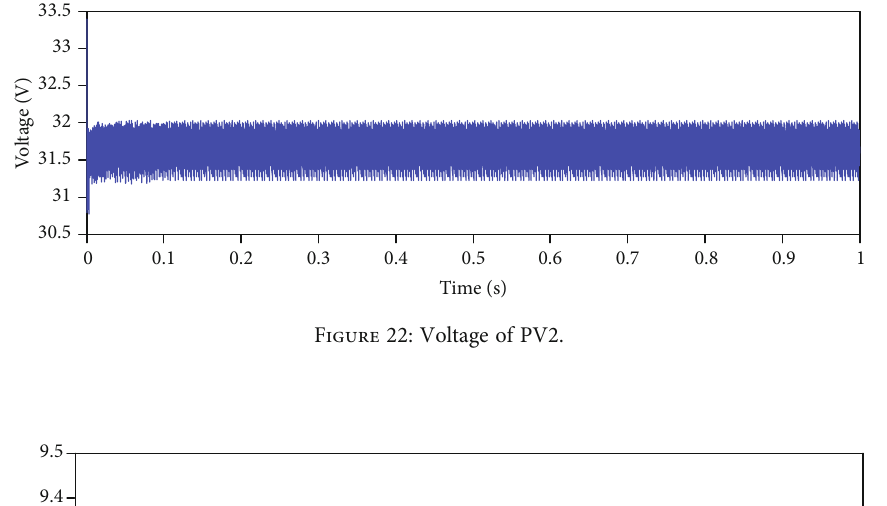
Figure 22: Voltage of PV2.